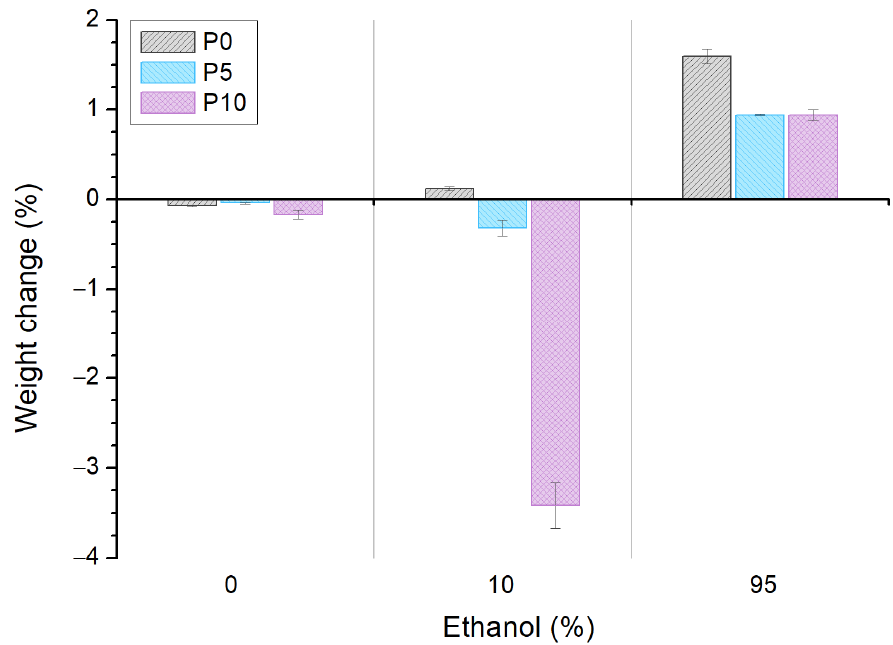
Figure 2. Weight change of poly(lactic acid) (P0) and active films (P5 and P10) after immersion in solutions with different ethanol concentration for 48 h at 25 °C.